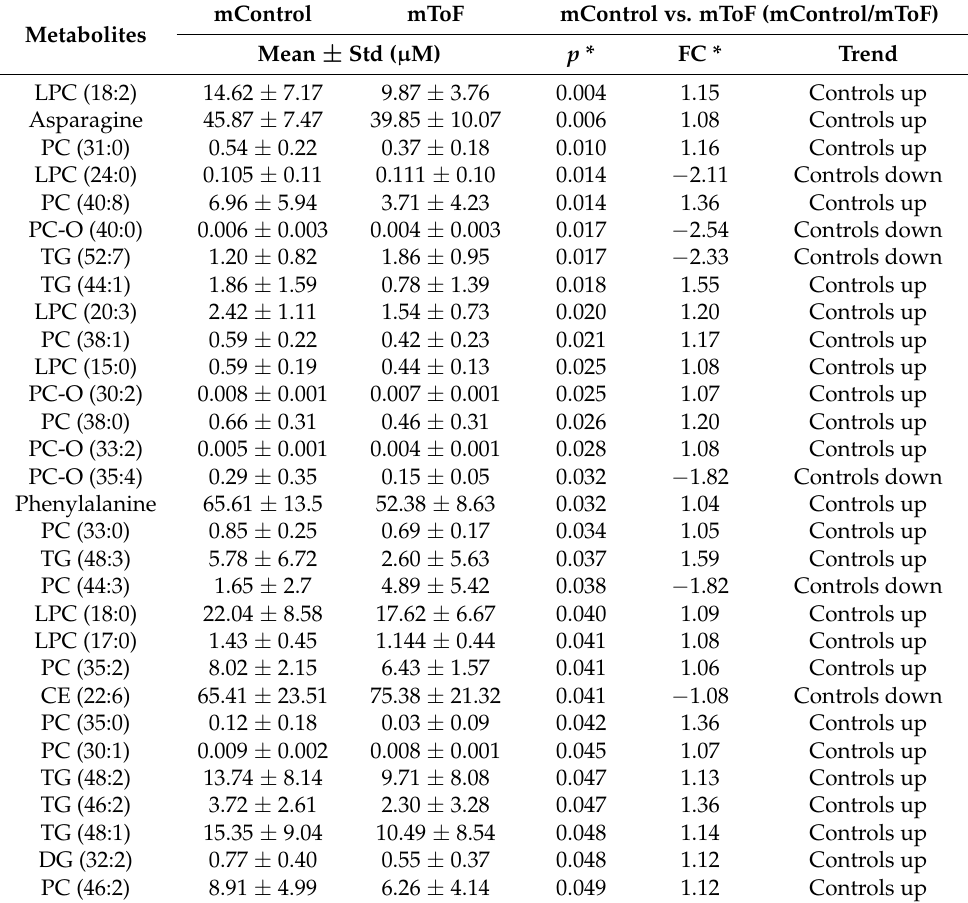
* FC = fold change. Raw p -values and FC represent differences between groups. Table 3. Significant metabolites between the mothers of control infants (mControl) compared to the mothers of infants with Tetralogy of Fallot (mToF), Arkansas site of NBDPS, 1997–2011. Metabolites